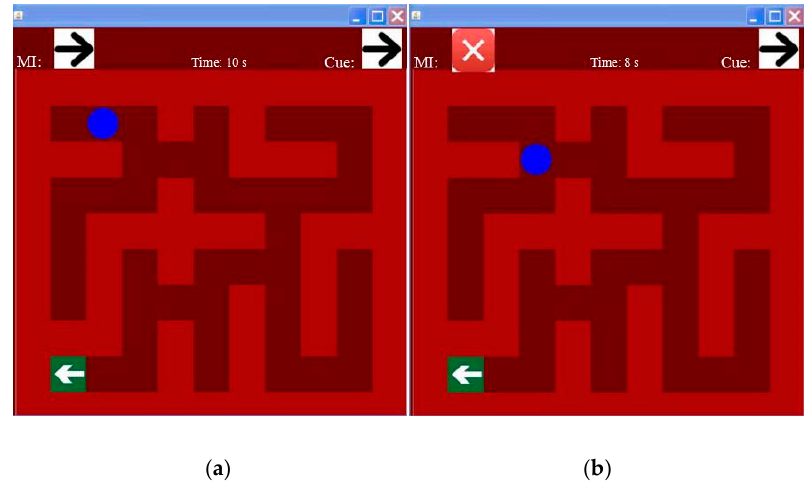
Table 1. The mapping relationship between the motor imagery tasks and movement directions.